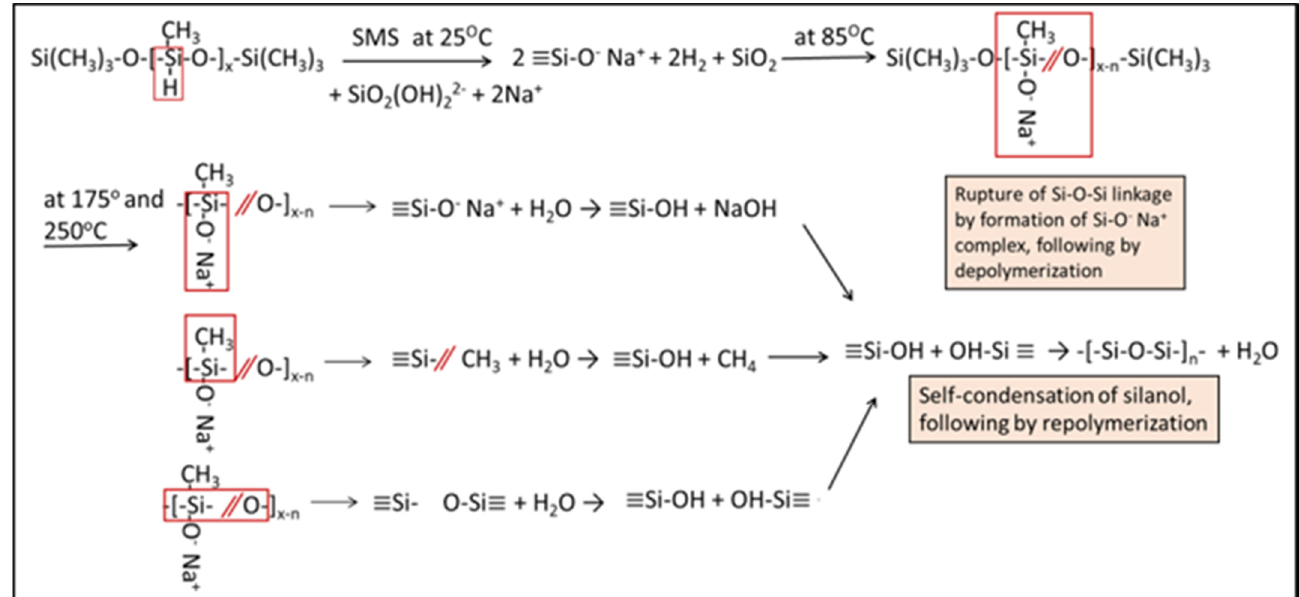
Figure 8. In situ hydroxylation and self-condensation pathways for PMHS/SMS blend at 85°, 175°, and 250 °C.